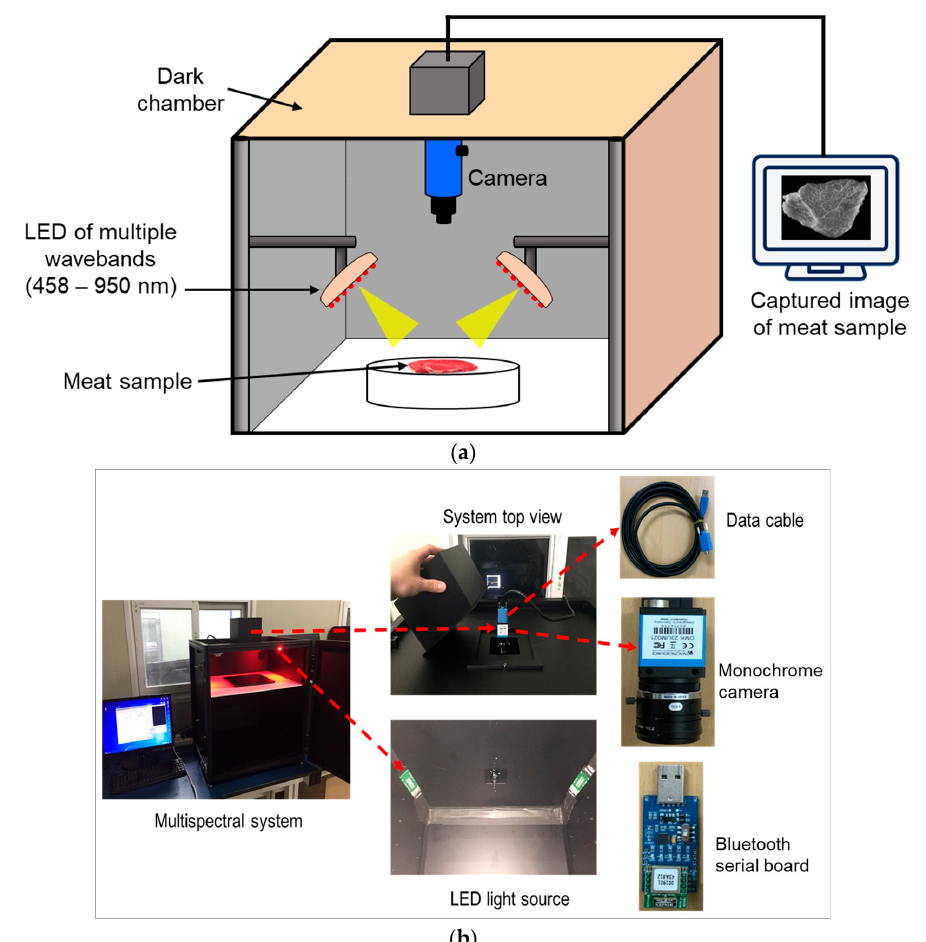
Figure 1. Schematic diagram ( a ) and photo ( b ) of the proposed multispectral imaging system for meat samples.